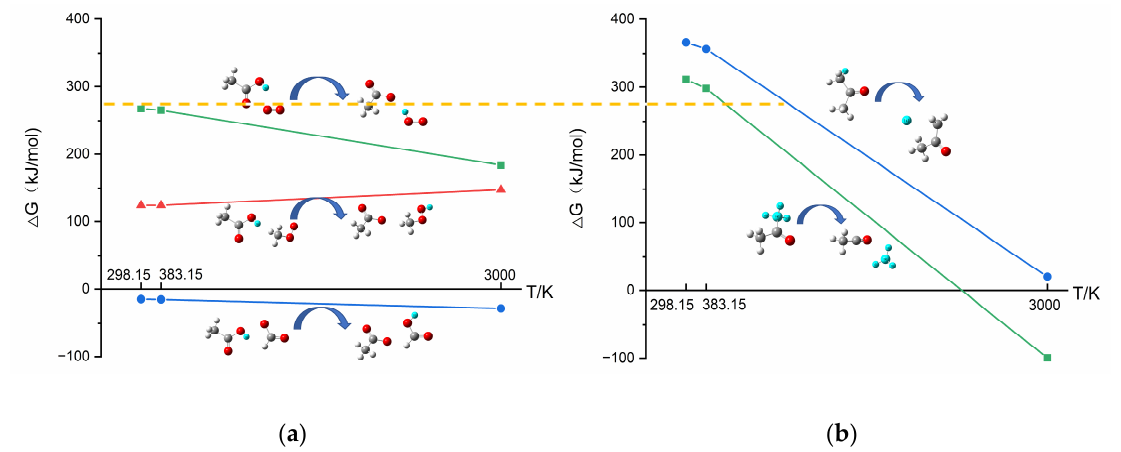
Figure 11. Gibbs free energy change for the first step reactions of acetic acid and acetone at different temperatures: ( a ) acetic acid; ( b )